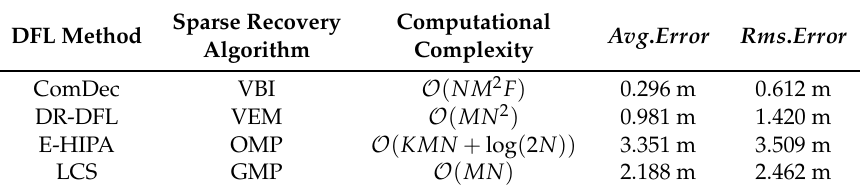
Table 2. Computational complexity and localization